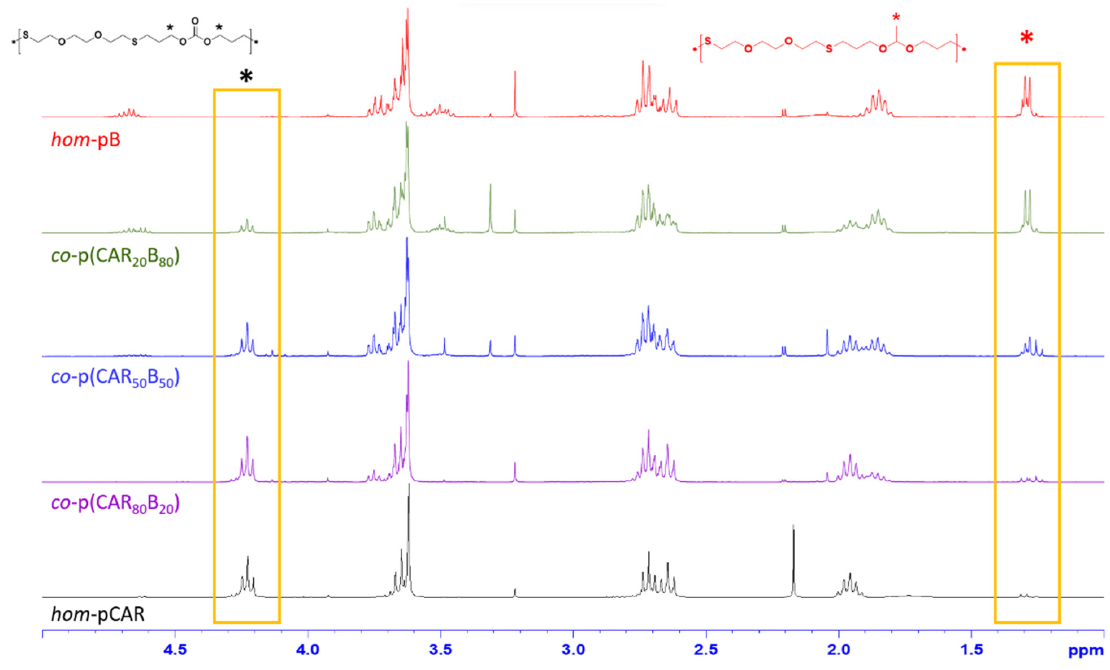
Figure 6. 1 H ‐ NMR spectra of hom ‐ pB, hom ‐ pCAR, and CAR/B copolymers. Figure 6. 1 H-NMR spectra of hom -pB, hom -pCAR, and CAR/B